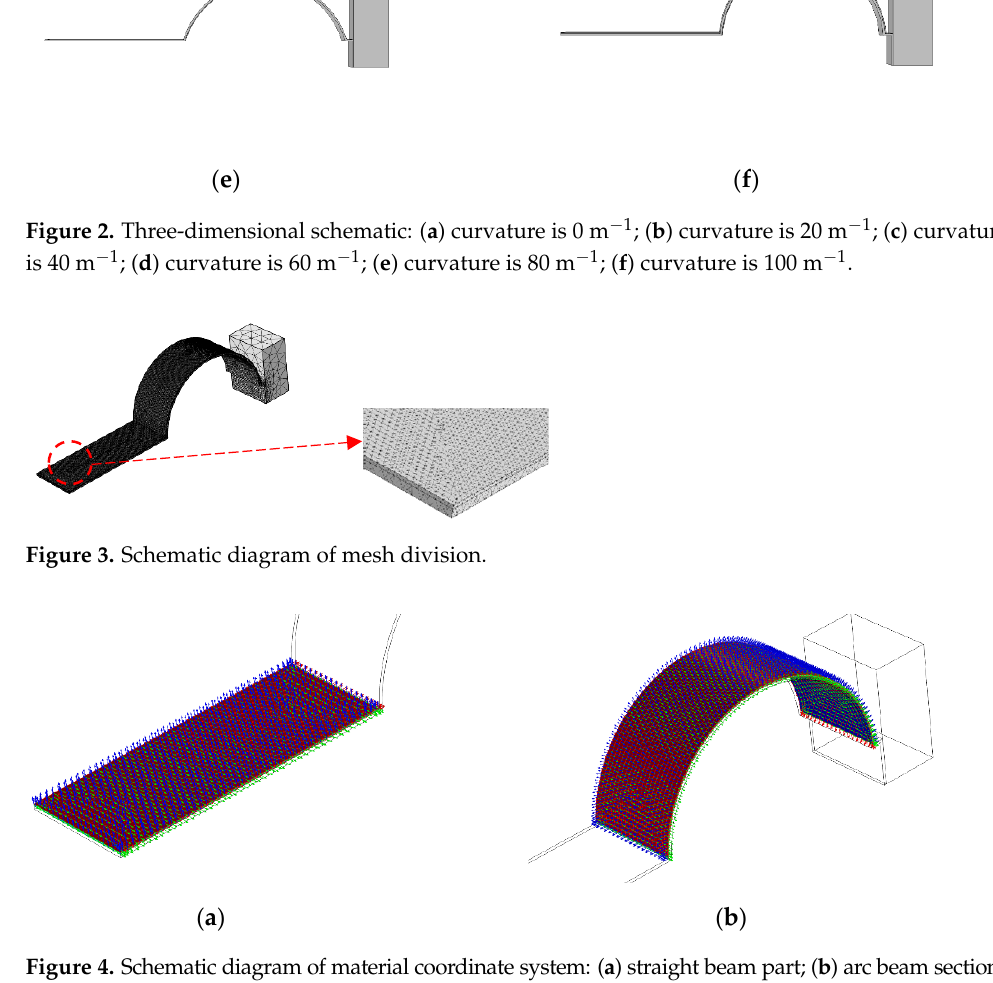
Figure 2. Three-dimensional schematic: ( a ) curvature is 0 m (cid:2879)(cid:2869) ; ( b ) curvature is 20 m (cid:2879)(cid:2869) ; ( c ) curvature is 40 m (cid:2879)(cid:2869) ; ( d ) curvature is 60 m (cid:2879)(cid:2869) ; ( e ) curvature is 80 m (cid:2879)(cid:2869) ; ( f ) curvature is 100 m (cid:2879)(cid:2869) .